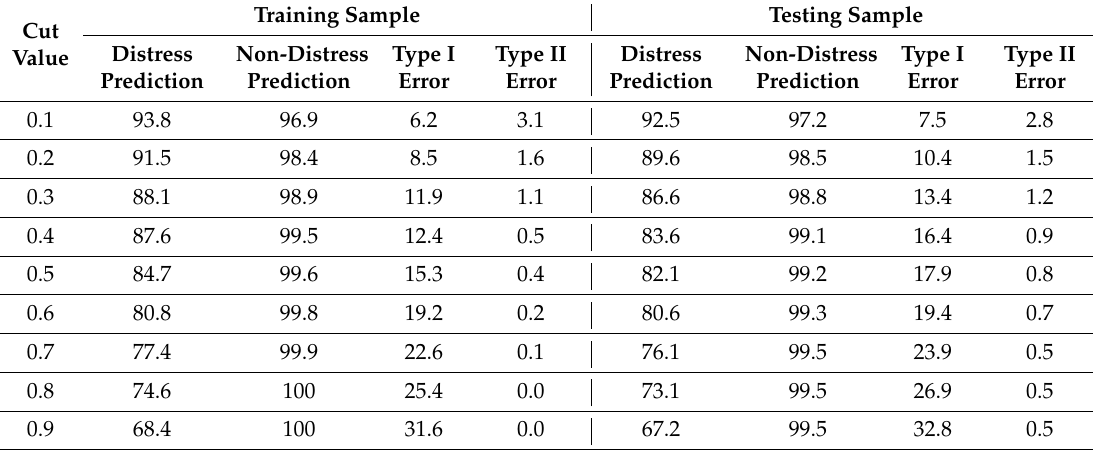
Table 7. Predictions for varied cut values